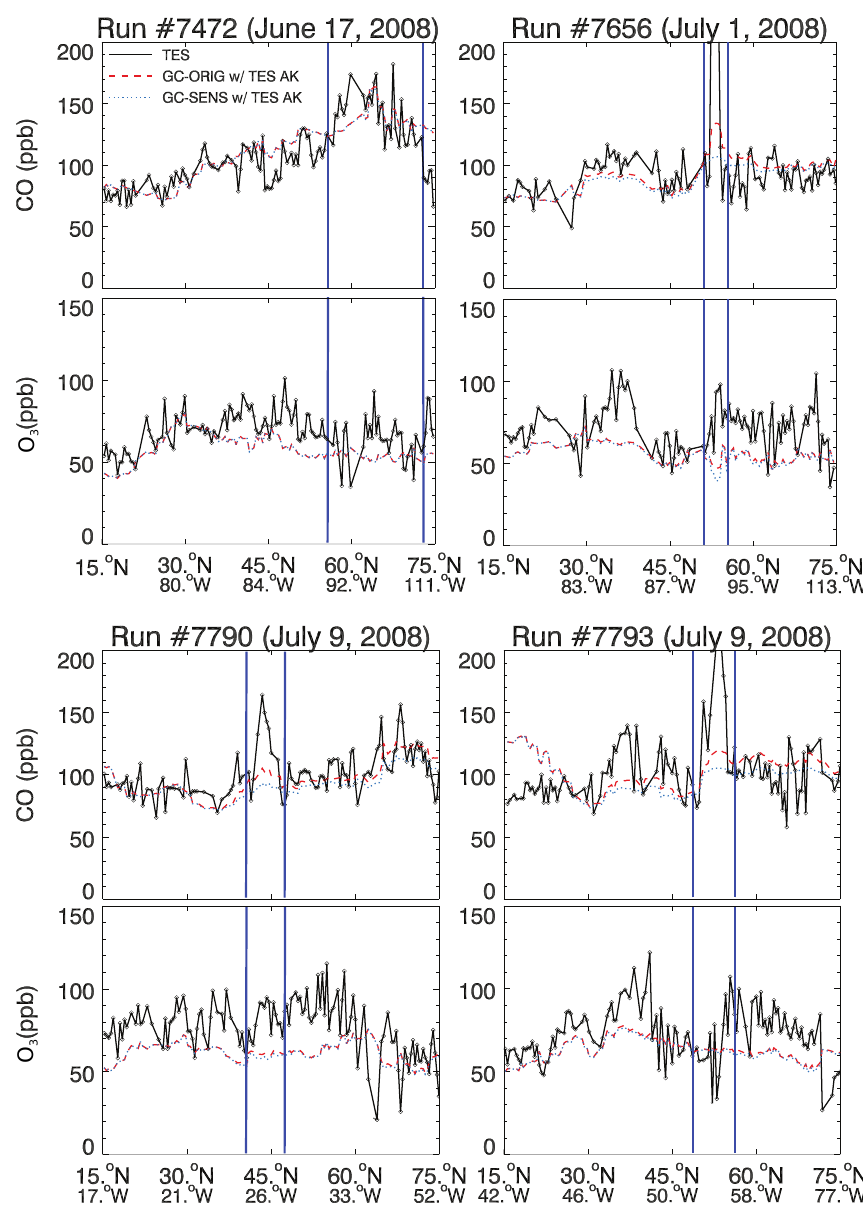
Fig. 12. CO and ozone mixing ratios at 510.9hPa for four TES runs influenced by biomass burning smoke from Canada. The solid black line is the TES retrieval, the red dashed line is the GC-ORIG model run results with the TES averaging kernel (AK) applied, and the dotted blue line is the GC-SENS model run results with the TES averaging kernel applied. The solid blue lines represent the approximate edges of the